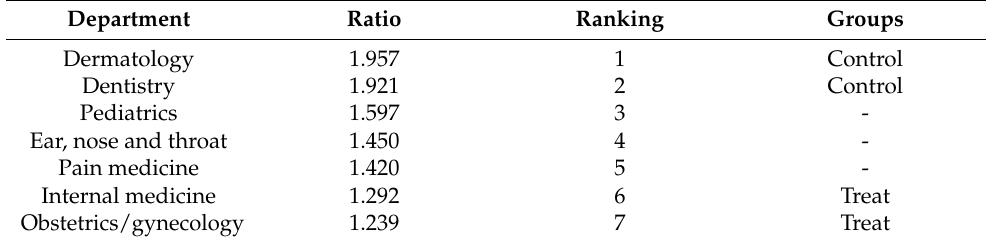
Table 1. Ranking of performance bonus and salary ratio. Department Ratio Ranking